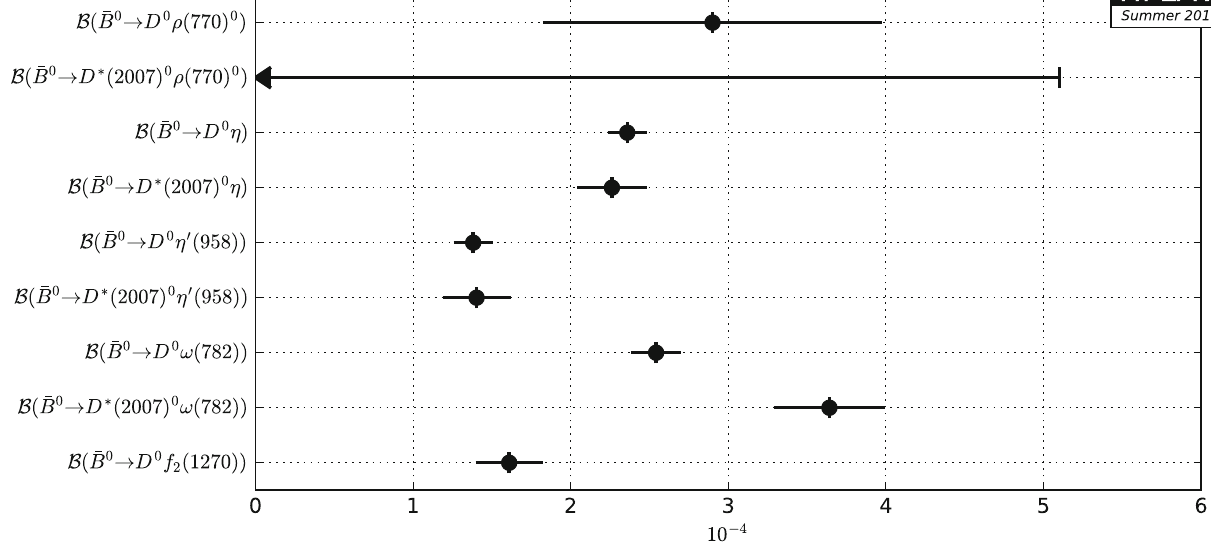
Fig. 70 Summary of the averages from Table 95